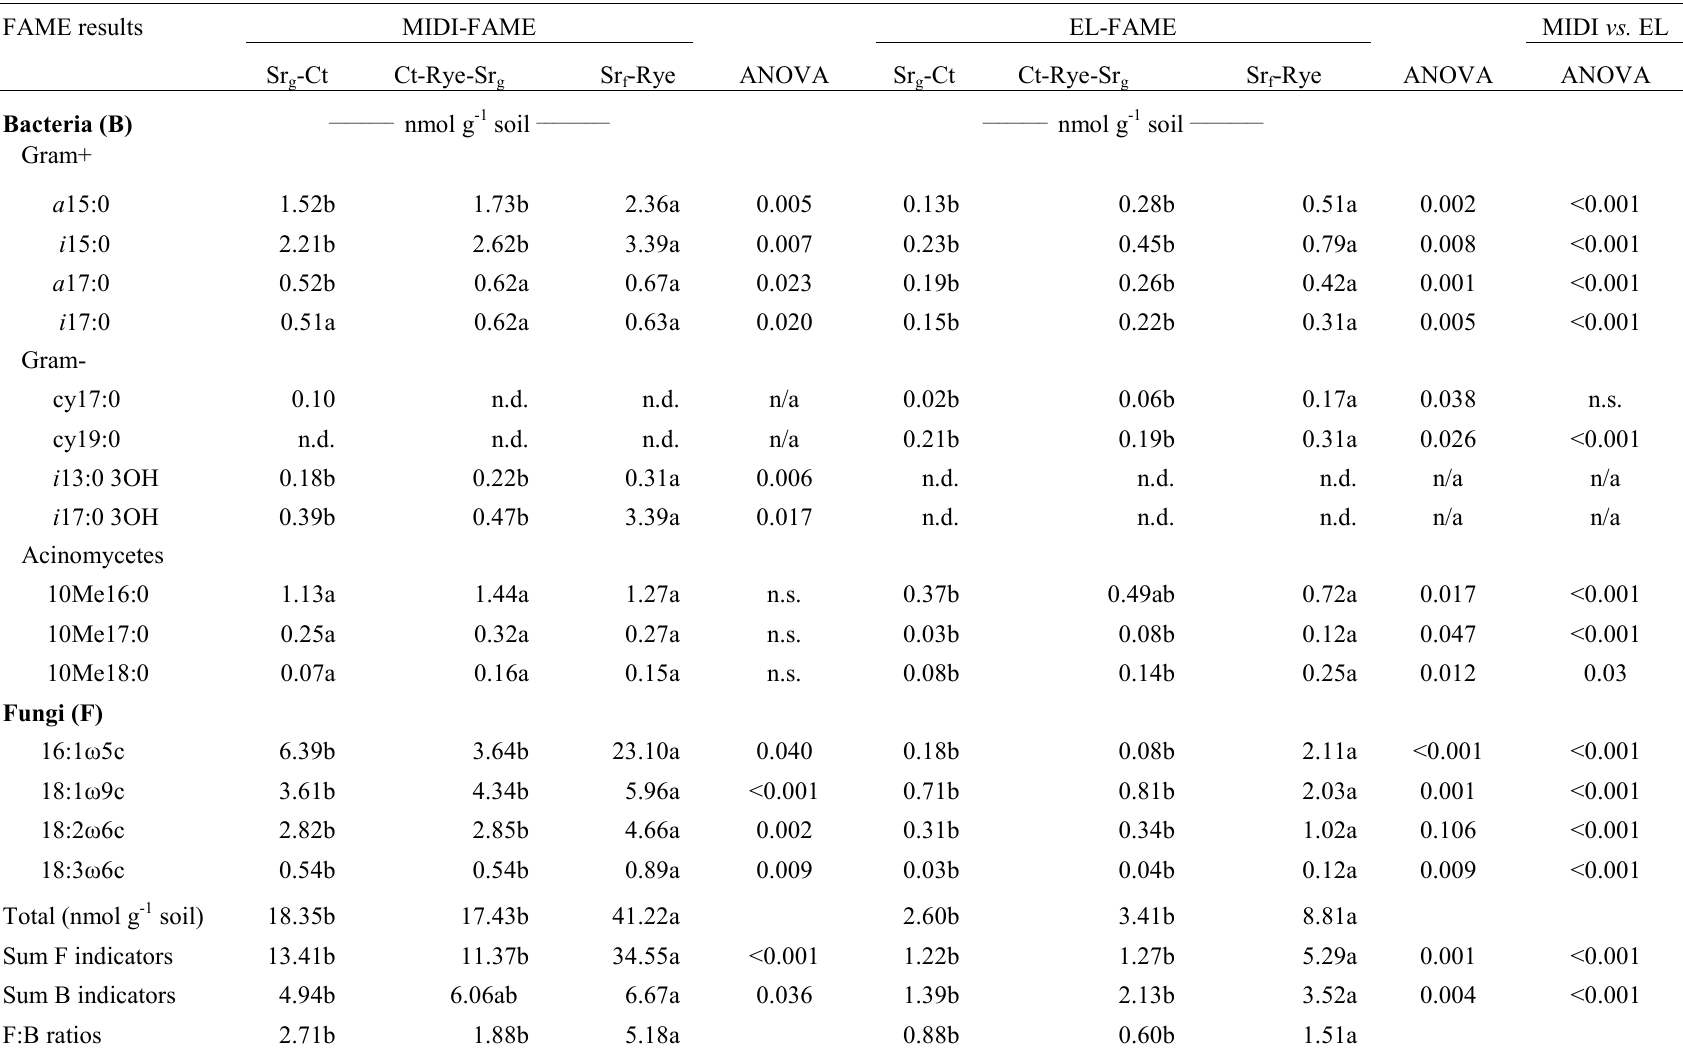
Table 2. Soil microbial community composition according to FAME indicators with MIDI and EL-methods under dryland no-tilled cropping systems (tillage treatments were not